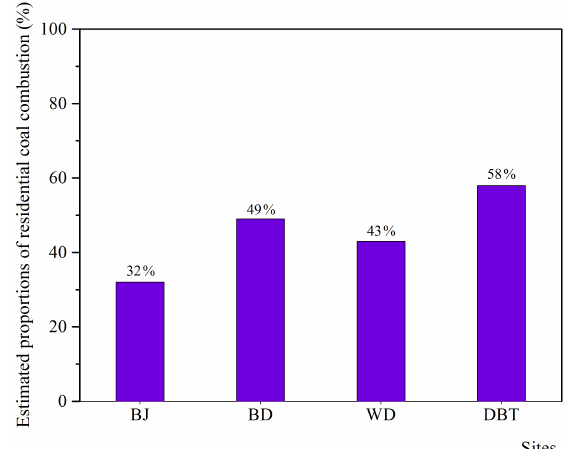
Figure 12. The estimated contributions of coal combustion to the PM 2 . 5 at the four sampling sites during the sampling period in the winter of